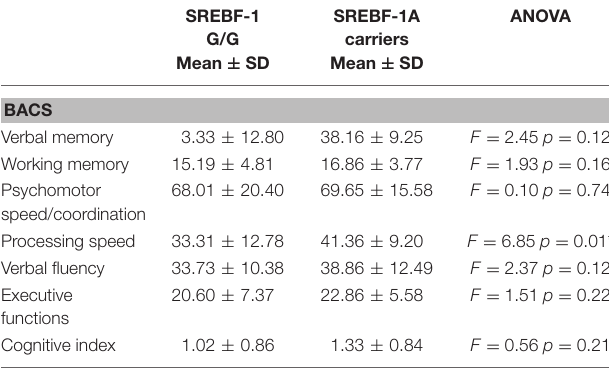
TABLE 6 | Cognitive measures (Brief Assessment of Cognition in Schizophrenia-BACS adjusted scores) in patients stratified by SREBF-1